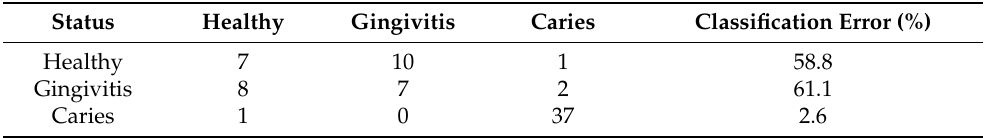
Table 2. Confusion matrix comparing random forest (RF) model predictions using biomarkers (top) with the assessments by dental specialists (left).